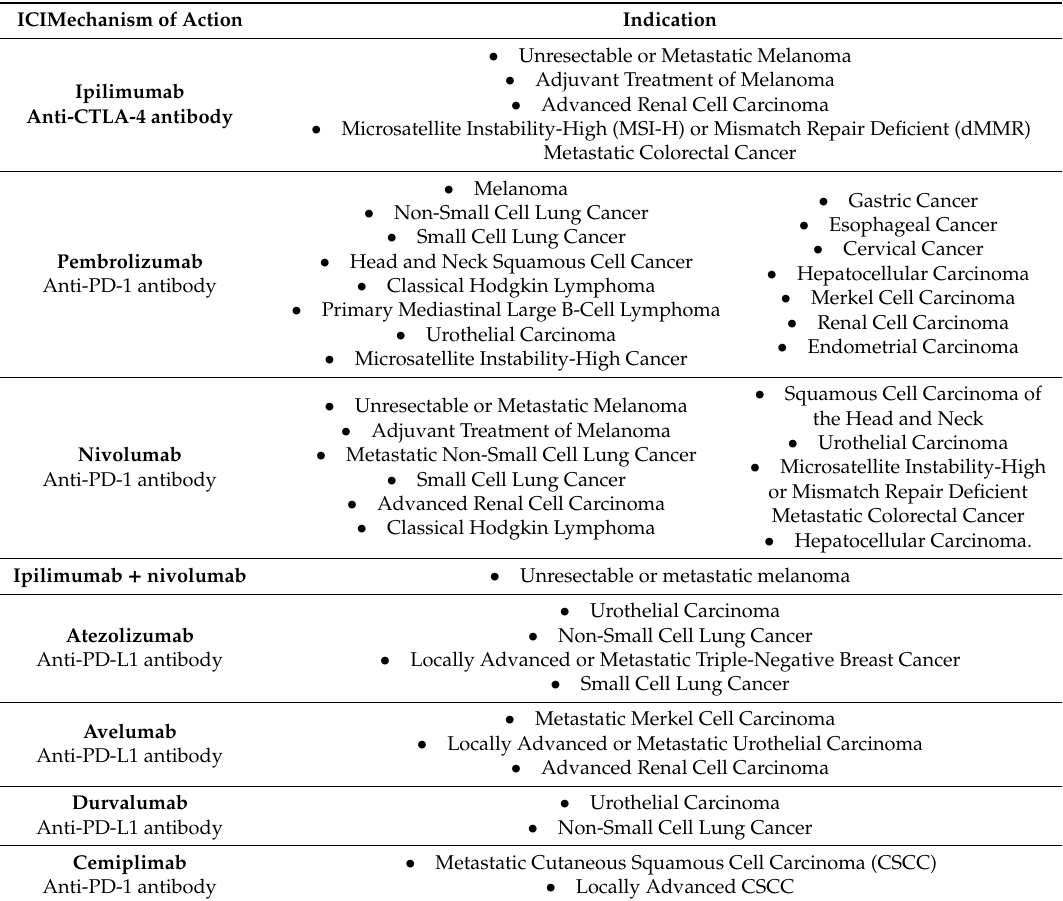
Table 1. Approved Immune-Checkpoint Inhibitors Updated on March 2019 according to United States Food and Drug Administration (U.S. FDA)